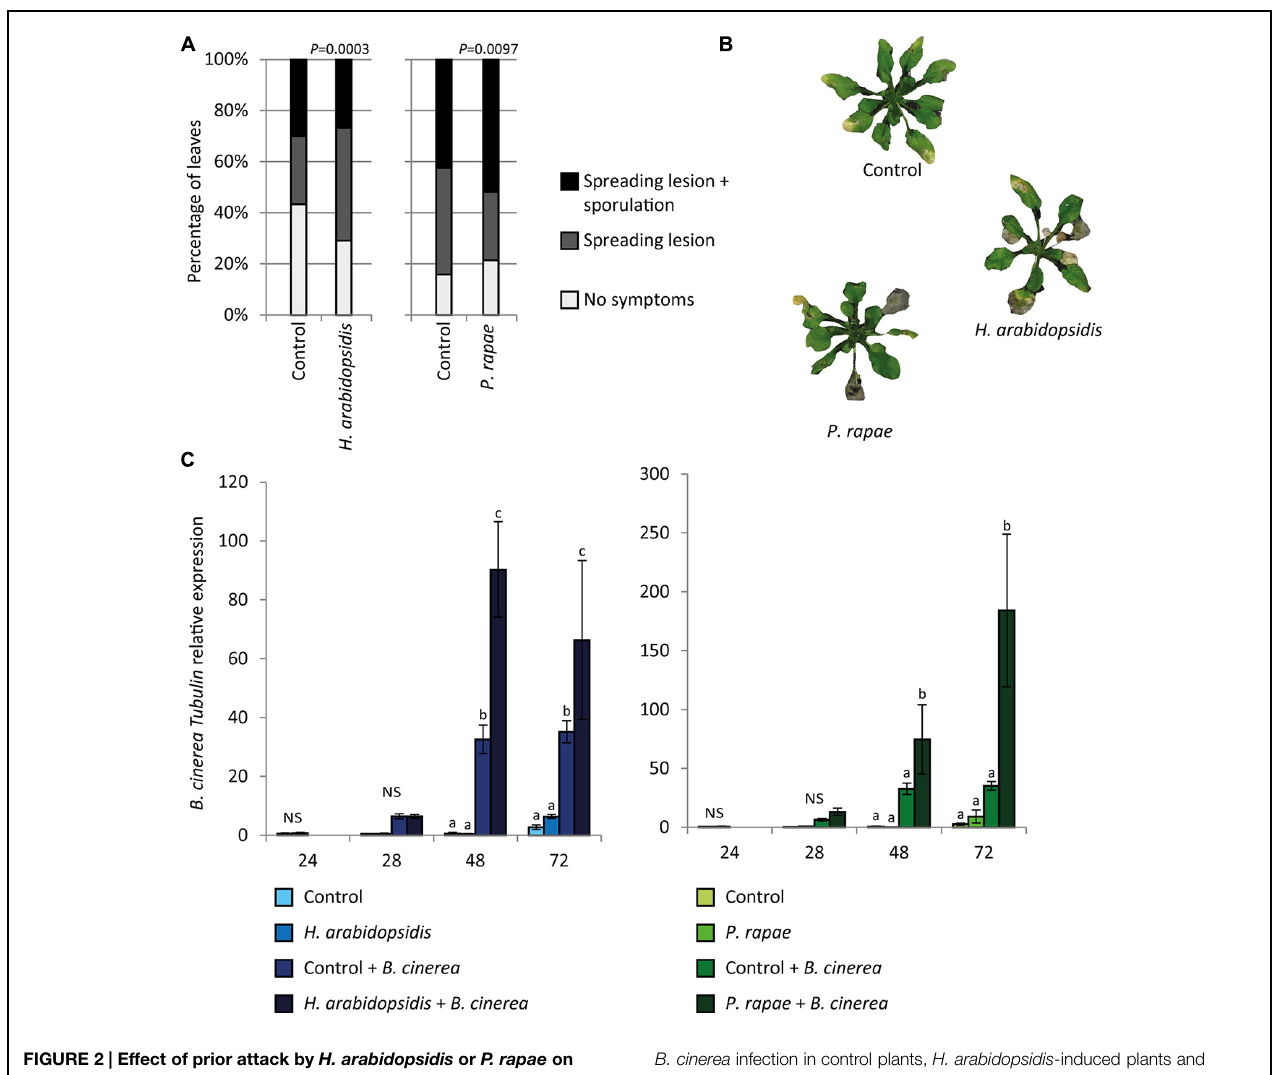
B. cinerea infection in control plants, H. arabidopsidis -induced plants and P. rapae -induced plants. (C) RT-qPCR analysis of B. cinerea Tubulin levels relative to Arabidopsis reference gene mRNA levels after single and double treatments. Samples were taken at the indicated time points after the first treatment (A,B) . Different letters indicate a statistically significant difference between the different treatments within one time point (ANOVA, Tukey post hoc test; P < 0.05; NS, not significant). Error bars represent SE, n = 3